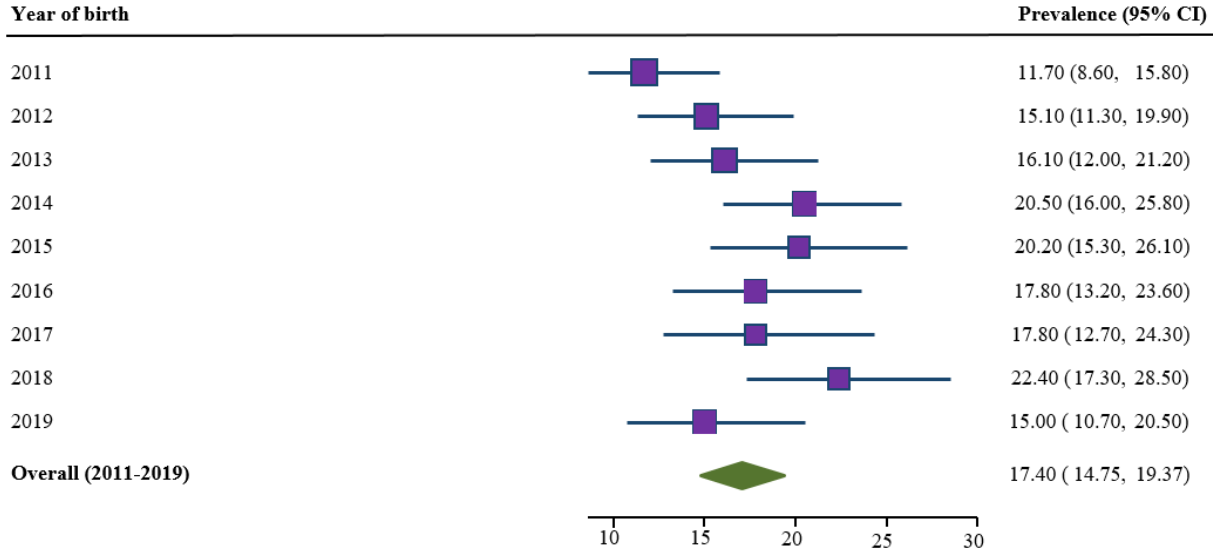
Figure 3. Trends in prevalence of smoking cessation during the second half of pregnancy for the period 2011–2019, SNSWLHD ( N = 2099). Table 1. Characteristics of the study population, number of babies with low birth weight, and percentage with 95% confidence interval (CI) in SNSWLHD ( N =